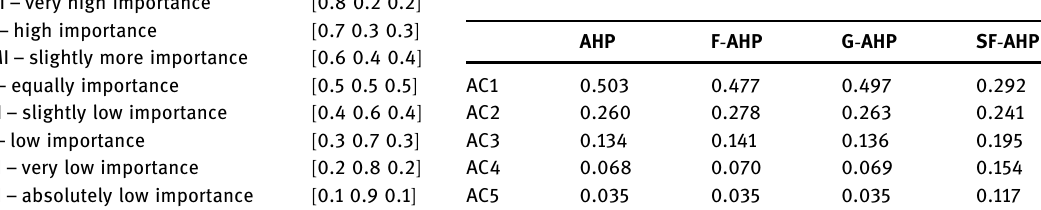
Table 4: AHP, F - AHP, G - AHP, and SF - AHP calculation